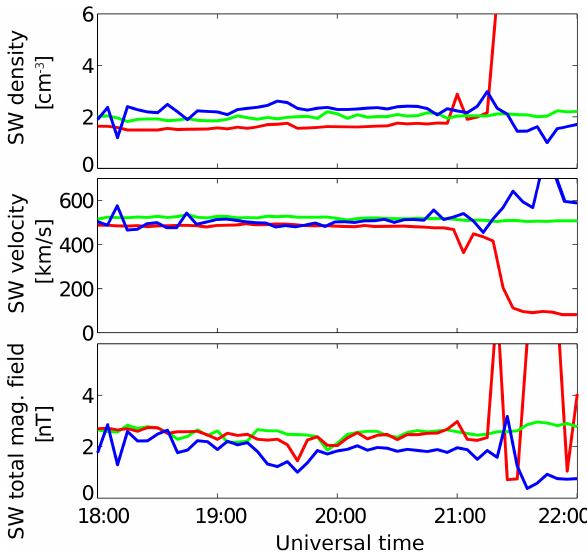
Figure 8. The reconstructed solar wind boundary conditions of the model density (top panel), the ion velocity (middle panel), and the magnetic field (bottom panel) for the magnetosheath transition on 16 September 2008 are shown in blue. Additionally, the THB (red) and OMNI (green) solar wind data during this time interval are shown.